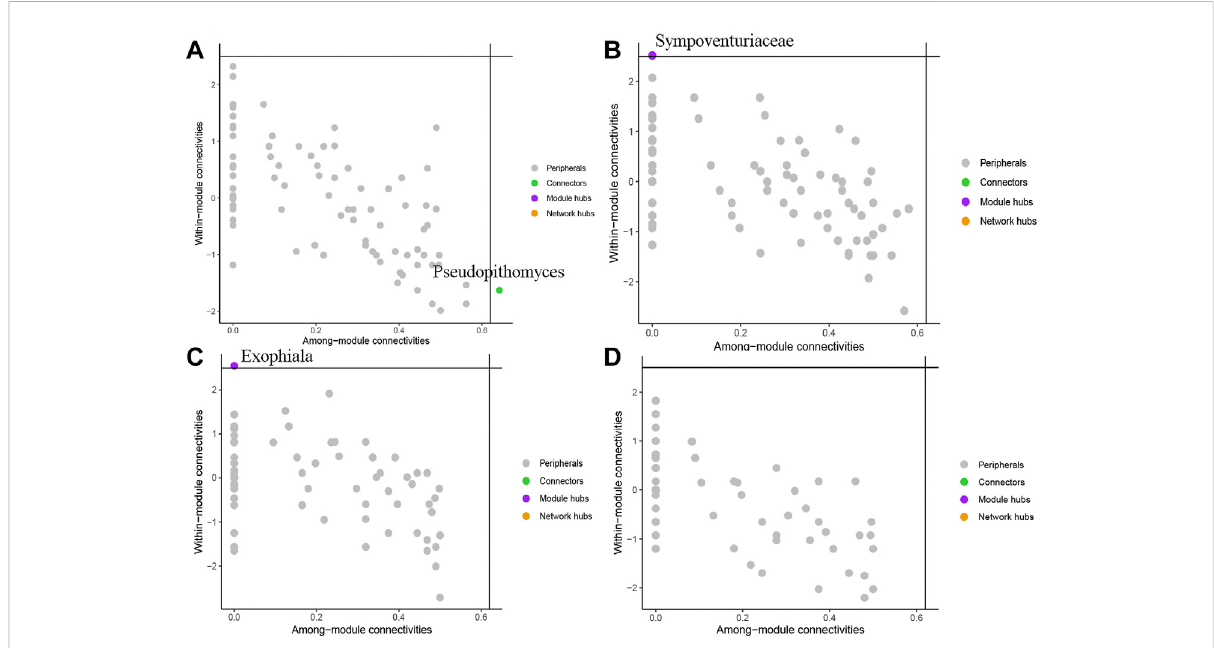
FIGURE 6 Soil fungi under different treatments were divided into network nodes by within-module connectivity (Zi) among-module connectivity (Pi) (A) thebulksoilofhealthyplants(BSH) (B) thebulksoilofthediseasedplant(BSD) (C) therhizospheresoilofhealthyplants(RSH) (D) therhizospheresoil of disease plants